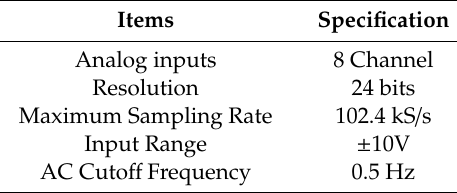
Table 4. Specifications of Board and DAQ.